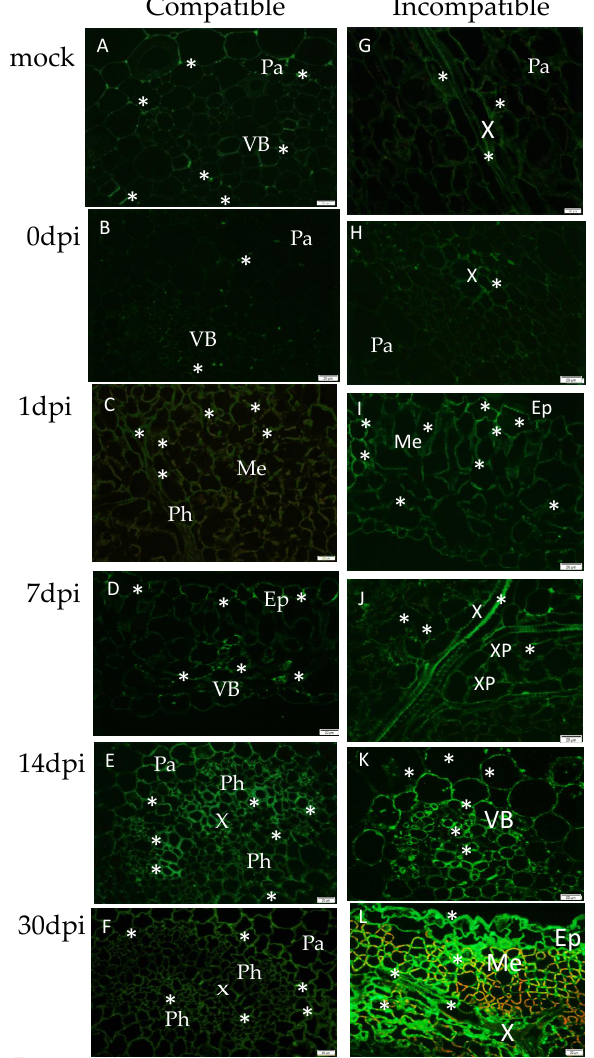
Figure7 Figure 7. Immunofluorescence localization of hydroxyproline-rich glycoprotein (HRGP) extensins in compatible ( B – F ) and incompatible ( H – L ) PVY NTN interactions. ( A ) HRGP green fluorescence signal (*) in xylem tracheary elements and parenchyma cells in mock-inoculated Irys potato plants. ( B ) HRGP weak green fluorescence signal in parenchyma cells around the vascular tissue at 0 dpi. ( C ) HRGPs in phloem and mesophyll cells at 1 dpi. ( D ) Green fluorescence signal in the epidermis and the vascular bundle at 7 days post-virus inoculation. ( E ) HRGPs in the vascular bundle and parenchyma cells around the vascular tissue at 14 dpi. ( F ) HRGPs in the vascular bundle and parenchyma at 30 days post-virus inoculation. ( G ) HRGP green fluorescence signal (*) in xylem tracheary elements in mock-inoculated S á rpo Mira potato plants. ( H ) HRGP green fluorescence signal in xylem tracheary elements in S á rpo Mira potato plants at 0 dpi. ( I ) HRGPs in the mesophyll and the epidermis at 1 dpi. ( J ) HRGPs in xylem tracheary elements and xylem parenchyma cells at 7 dpi. ( K ) HRGPs in the vascular bundle at 14 dpi. ( L ) HRGPs in the epidermis, mesophyll, and xylem tracheary elements at 30 days post-virus inoculation; bar 20 µ m. Ep—epidermis; Me—mesophyll; Pa—parenchyma; Ph—phloem; VB—vascular bundle; X—xylem tracheary elements; XP—xylem